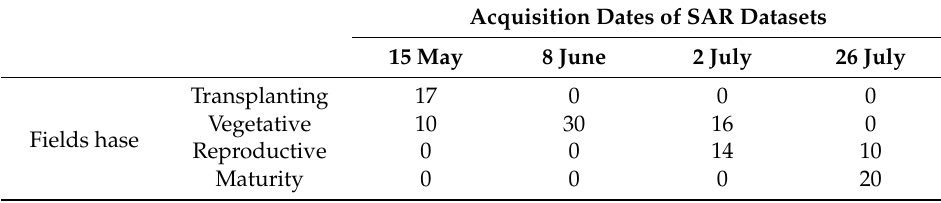
Table 2. The number of sample sites in different phenological phases when SAR datasets were acquired. On 15 May 2016, fields where three sample sites were located were not planted yet.